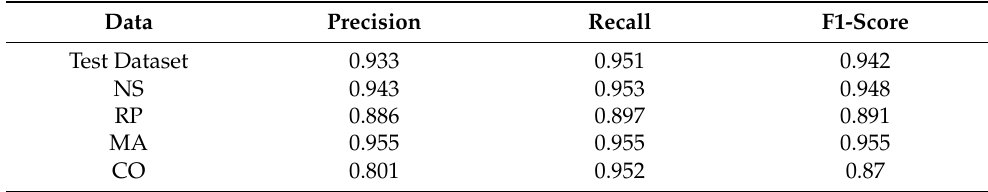
Table 2. Performance metrics of the